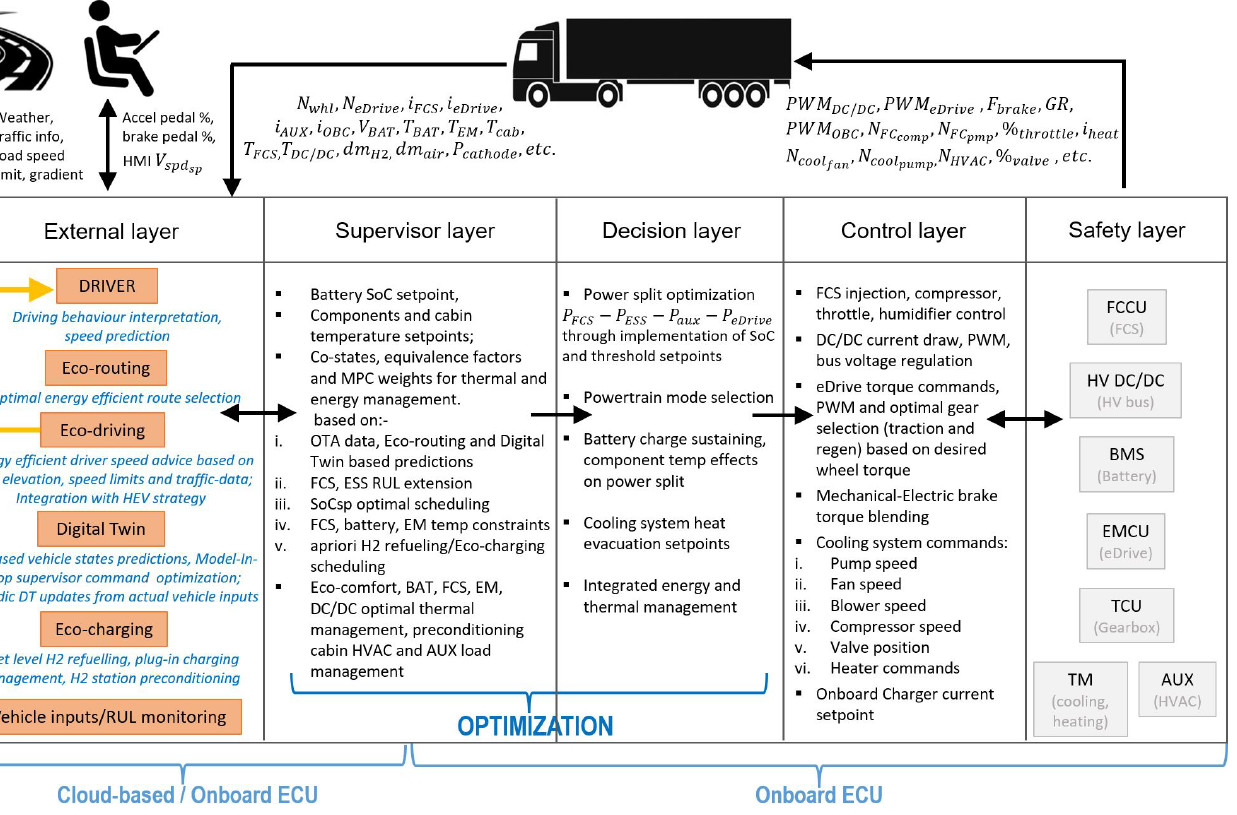
Figure 14. Integrated multi-level energy and thermal management framework including external layer, supervisor layer, decision layer, control layer and safety layer for complete powertrain